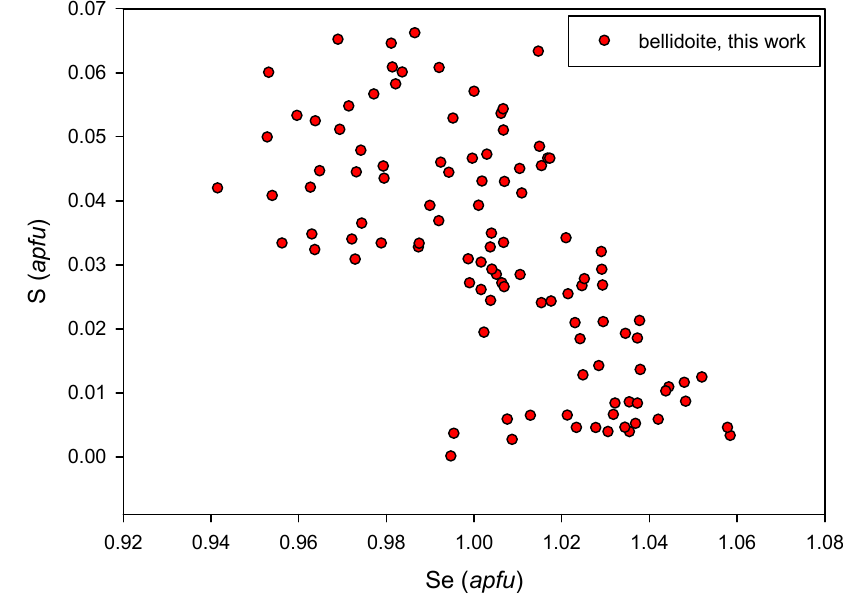
Figure 10. Se vs. S ( apfu ) graph for bellidoite from P ř íbram.